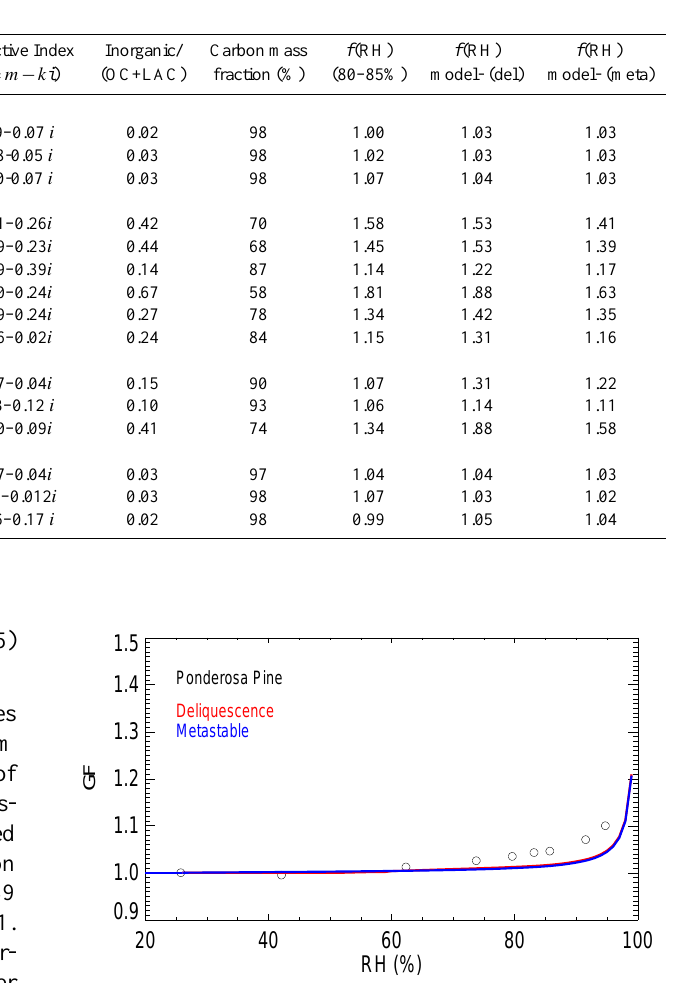
Table 2. Measured and derived smoke characteristics for biomass fuels burned during FLAME 2006. Shape factors ( χ ) were derived from DMPS data (see text), POM/OC refers to the multiplier used to convert organic carbon (OC) to particulate organic matter (POM). Density and refractive index correspond to the dry mixed aerosol. “Carbon mass fraction” refers to the sum of POM and light absorbing carbon (LAC), while the “inorganic” refers to salts only and is divided by the sum of OC and LAC. Measured f (RH) is reported for RH=80–85%, with dry RH=20–25%, wavelength of 530nm and experimental uncertainty of ± 0.08. The f (RH) results from the E-AIM model for deliquescence (“del”) and metastable equilibrium (“meta”) also refer to 80–85% RH and the same wavelength. Fuel names are listed in the first column and separated into fuel types.